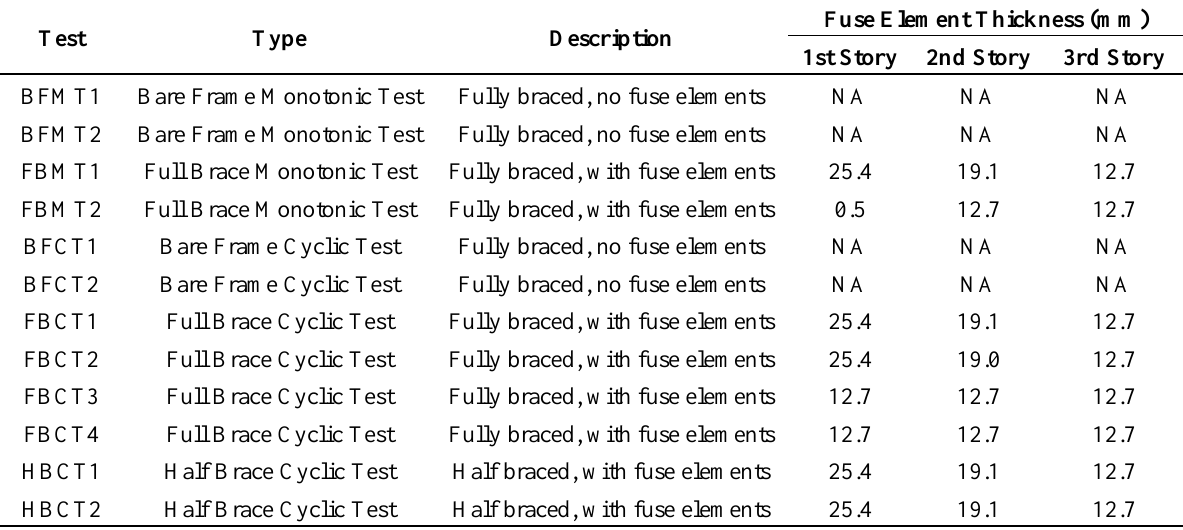
Table 3. Cyclic testing program test